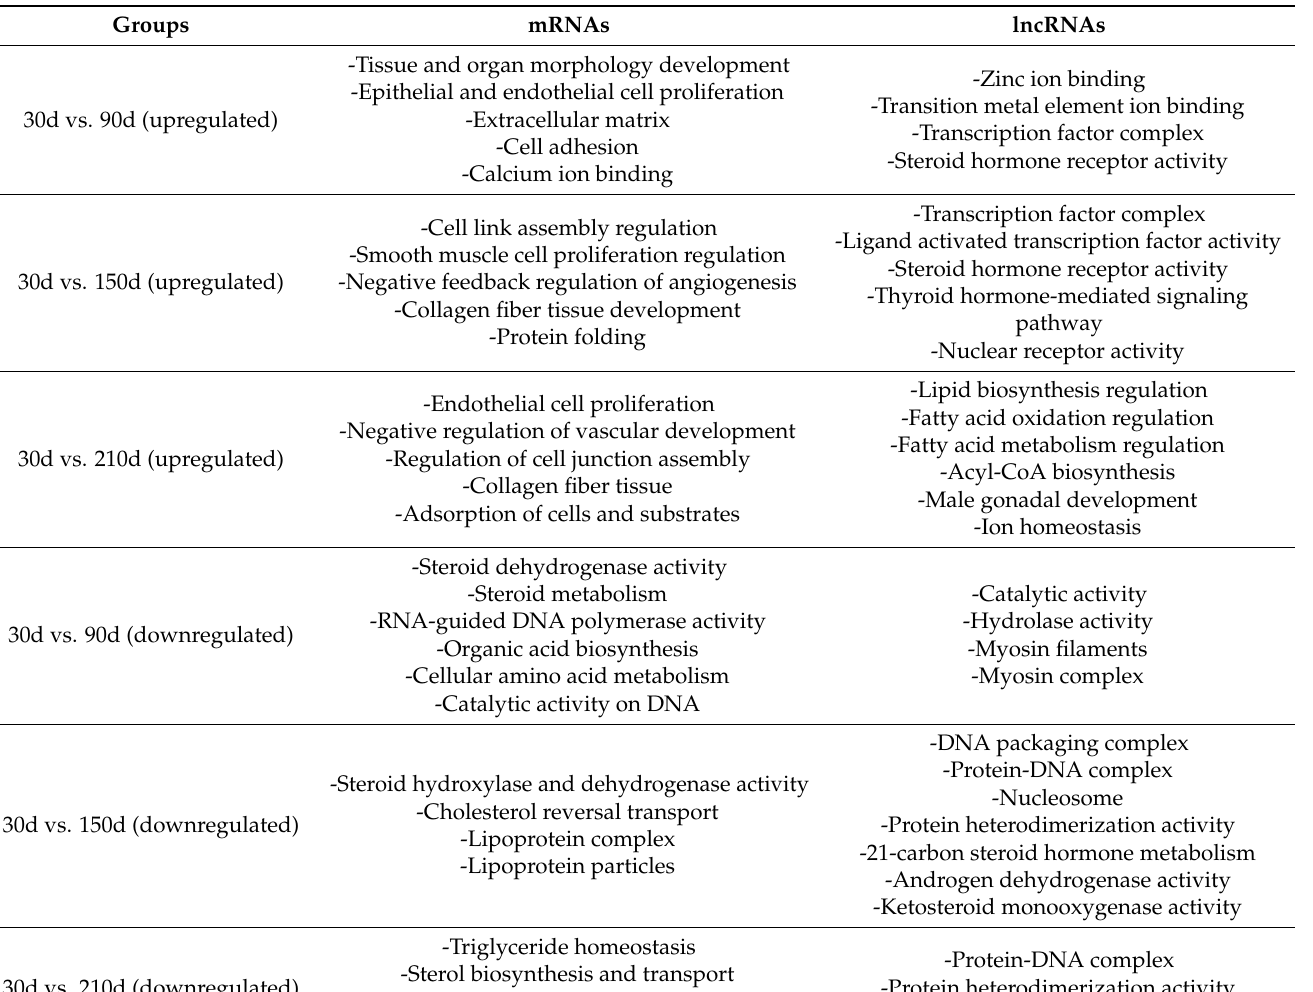
Table 2. Go enrichment analysis of mRNAs in closed groups (30d vs. 90d, 30d vs. 150d, and 30d vs. 210d). Groups